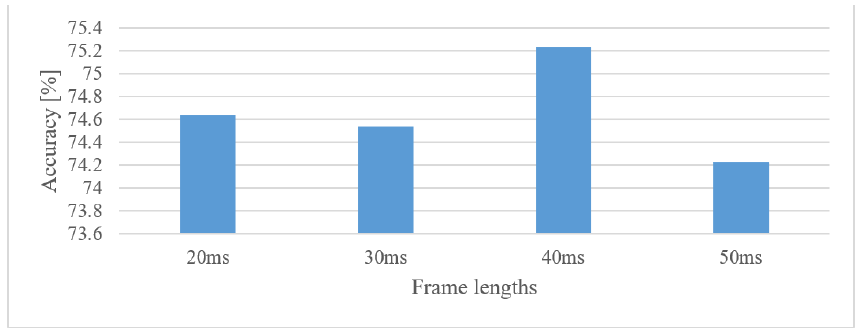
Figure 8. Averaged accuracies for 20, 30, 40, and 50 ms frame lengths in the case of 0–22050 Hz spectrograms.